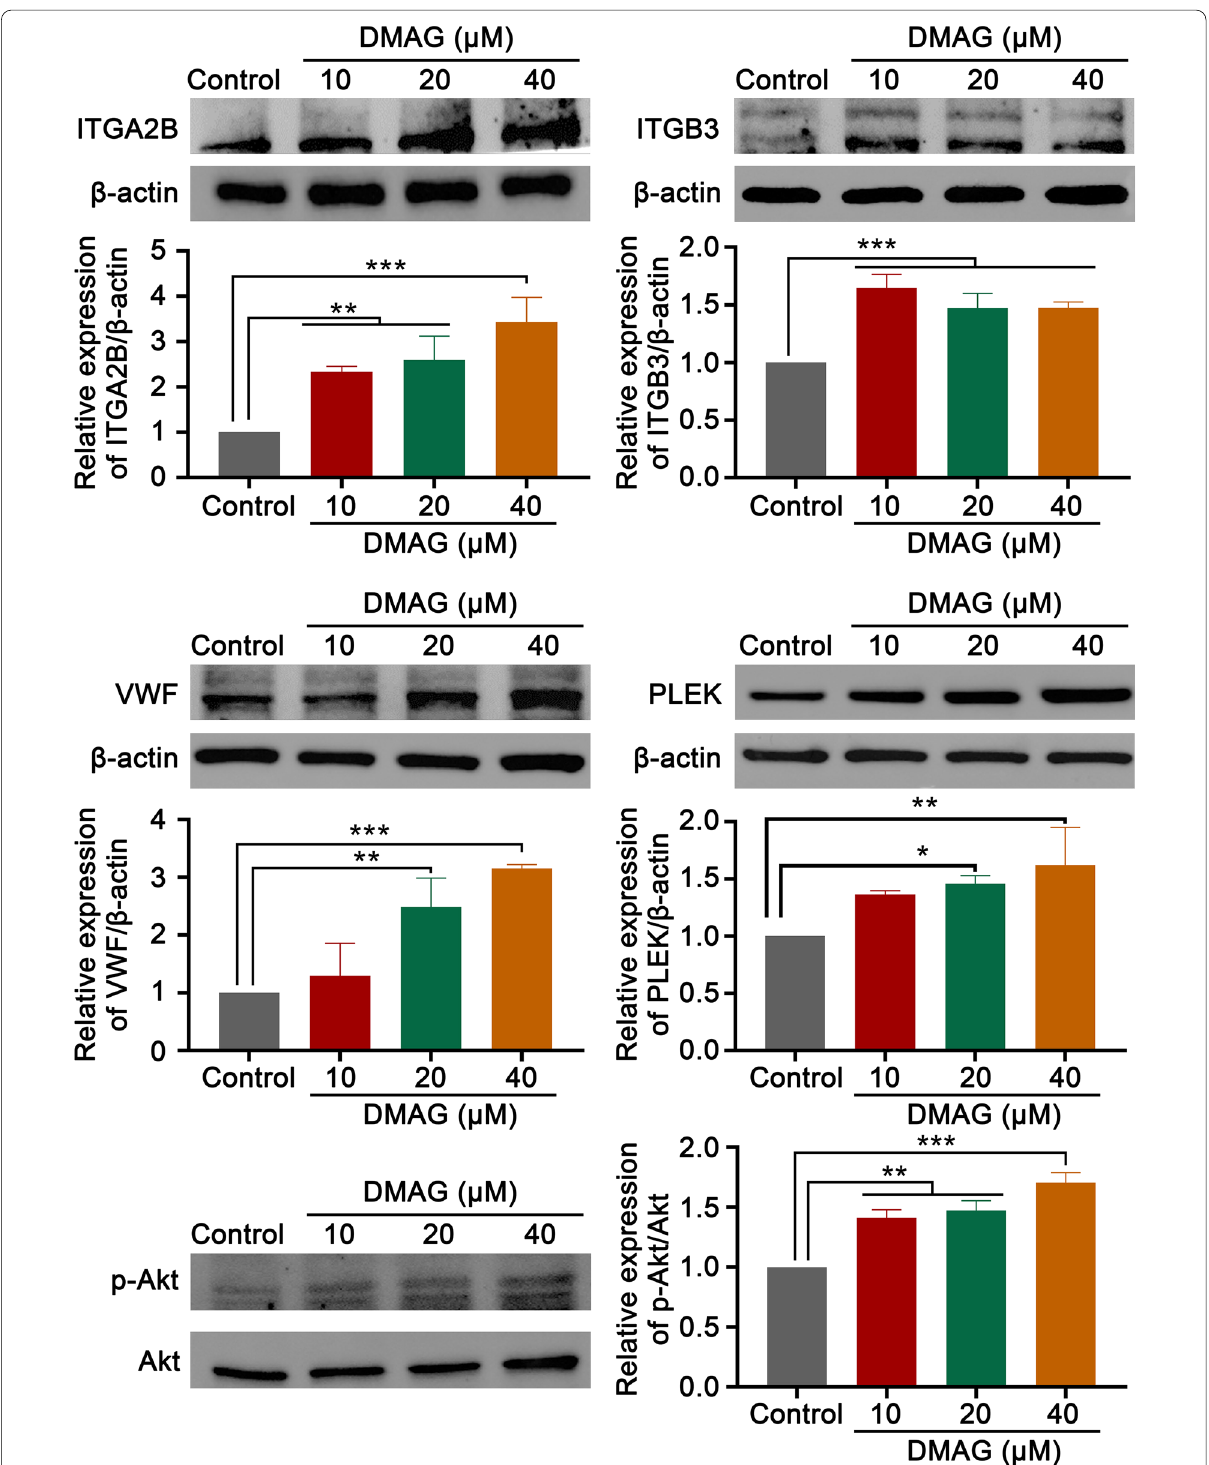
Fig. 7 Western blot analysis of expression of core targets of DMAG. The expressions of ITGA2B, ITGB3, VWF, PLEK and p‑Akt were detected by western blot after HEL cells were treated with DMAG (10, 20 and 40 μM) for 4 days. The data represent the mean experiments; * p < 0.05, ** p < 0.01, *** p < 0.001, compared to the control